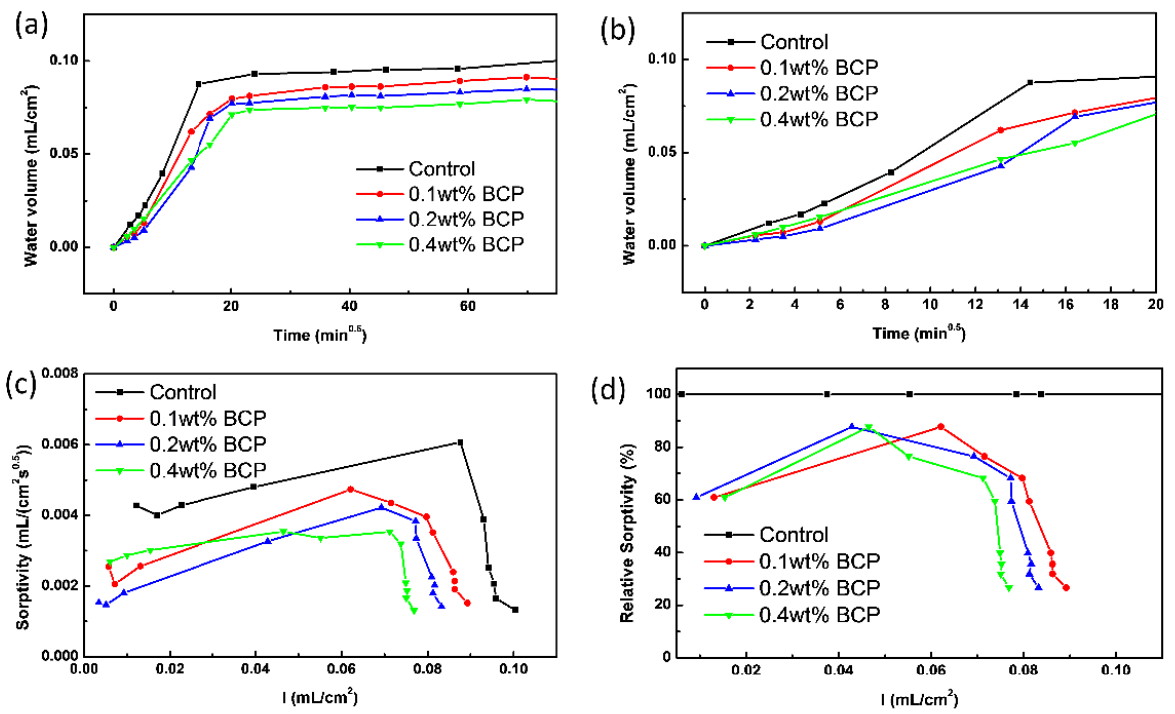
Figure 6. Water absorption amount variation with √ t for control and BCP doped cement pastes samples ( a ) at full time and ( b ) at an early stage, ( c ) evolution of water sorptivity, and ( d ) relative water sorptivity variation with water absorption amount for control and BCP doped cement pastes samples.